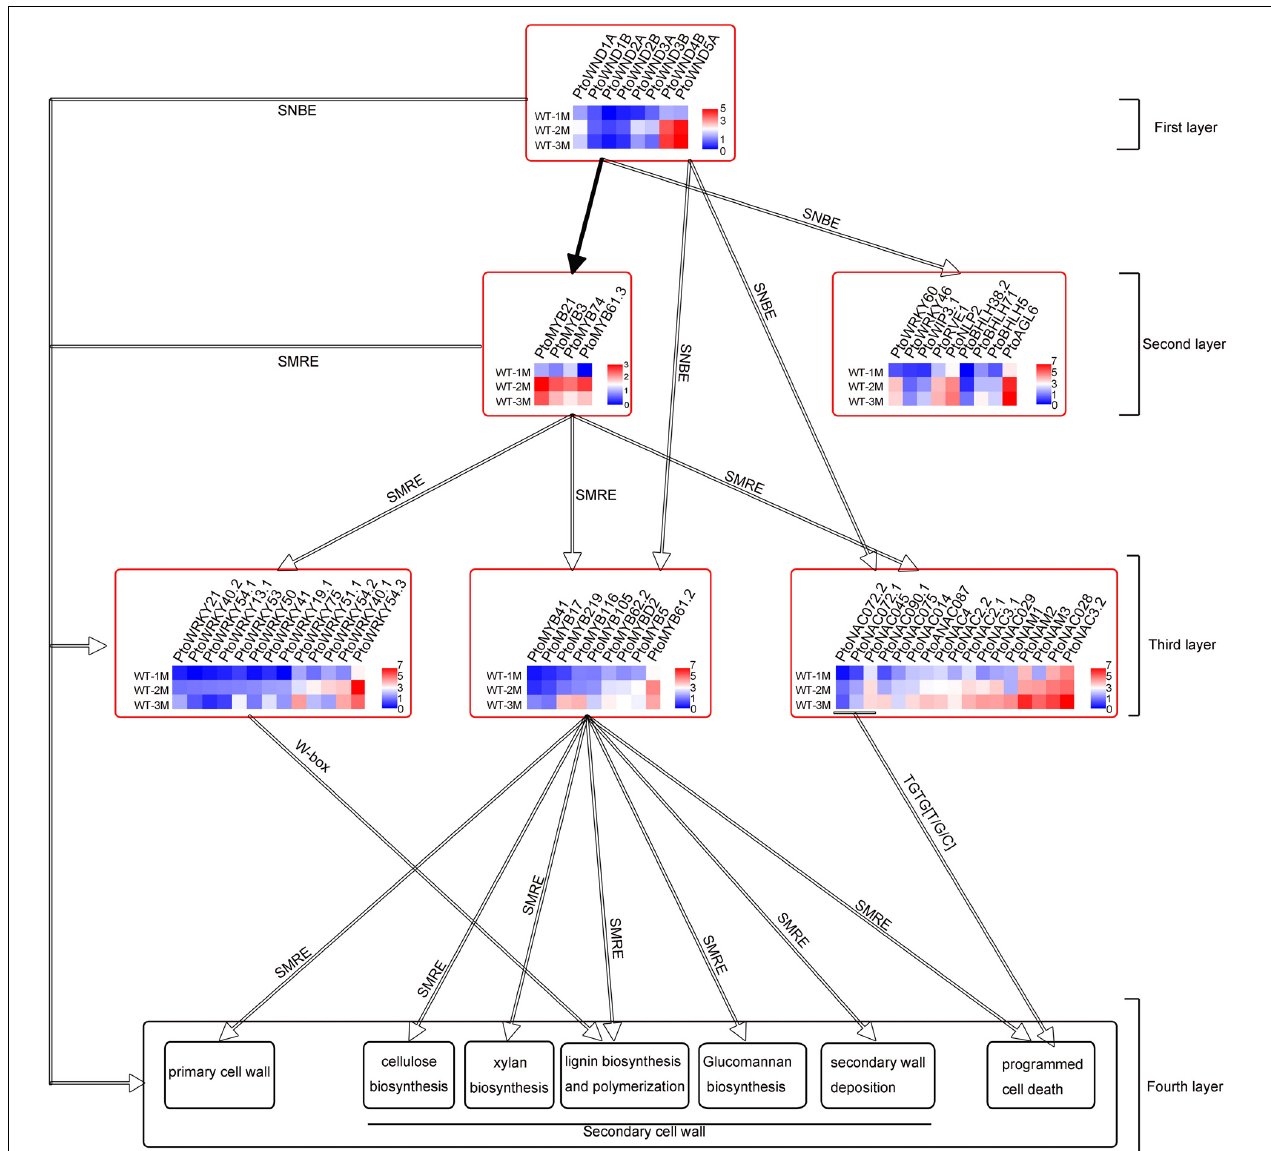
FIGURE 4 | Four-layer PtoWNDs–mediated TRN depicting transcriptional regulation of cell wall biosynthesis and PCD in P.tomentosa during xylem development. The hollow arrows indicate predicted proteins by cis -acting elements; black solid arrows indicate proteins confirmed in previous